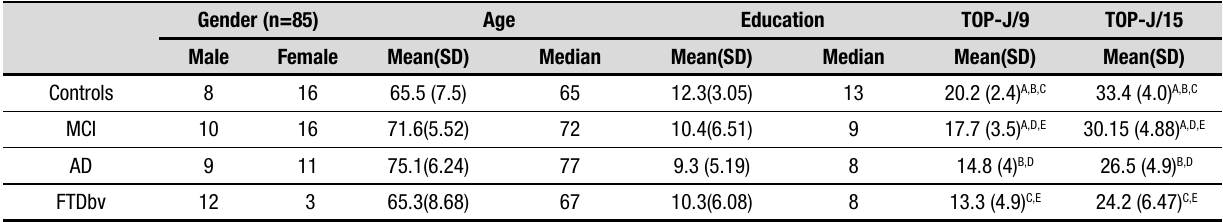
Table 2. Sociodemographic profile and TOP-J/Br results Gender